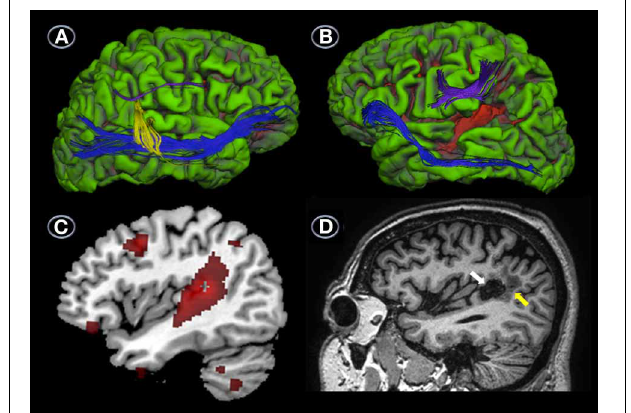
FIGURE 4 | DTI, MRI, and PET. Uninflated surface of the right (A) and left hemispheres (B) (FreeSurfer reconstruction) of the patient with conduction aphasia (JGG) showing gyri cultured in green with sulci shown in red. DTI of right hemisphere perisylvian pathways superimposed on JJG anatomical MRI shows a complete lack of the direct temporo-frontal section of the AF in the right hemisphere. The indirect temporo-parietal (yellow) and parieto-frontal (purple) segments are present but very small. White matter tract reconstruction in the left hemisphere shows that the fronto-parietal segment of the AF (purple) was intact, but the temporo-parietal and temporo-frontal segments were unreconstructable, and seemingly destroyed by the lesion (B) . The ventral stream (inferior frontal-occipital fasciculus/extreme capsule) was reconstructed successfully in both hemispheres (A,B) . The surface image of the left hemisphere depicted in (B) also shows the infarction (red area) involving the posterior-superior and middle temporal gyri and part of the supramarginal gyrus. Parasaggital T 1 -weighted image shows a component of the infarction in the supramarginal gyrus (white arrow) surrounded by perinecrotic tissue (yellow arrow) (C) . Parasaggital image of the 18 FDG-PET (MRIcroN) showing an area of reduced metabolic activity in the left temporoparietal region (red) (D) which is slightly larger at the level of the posterior temporal gyrus than the area of infarction depicted in (C) . Less voluminous foci of reduced metabolic activity (all in red) are also shown in the left middle frontal gyrus (Brodmann’s area 6), lateral orbitofrontal cortex (Brodmann’s area 11), inferior temporal gyrus (Brodmann’s area 20), and cerebellum (D) . See further details in Table 4